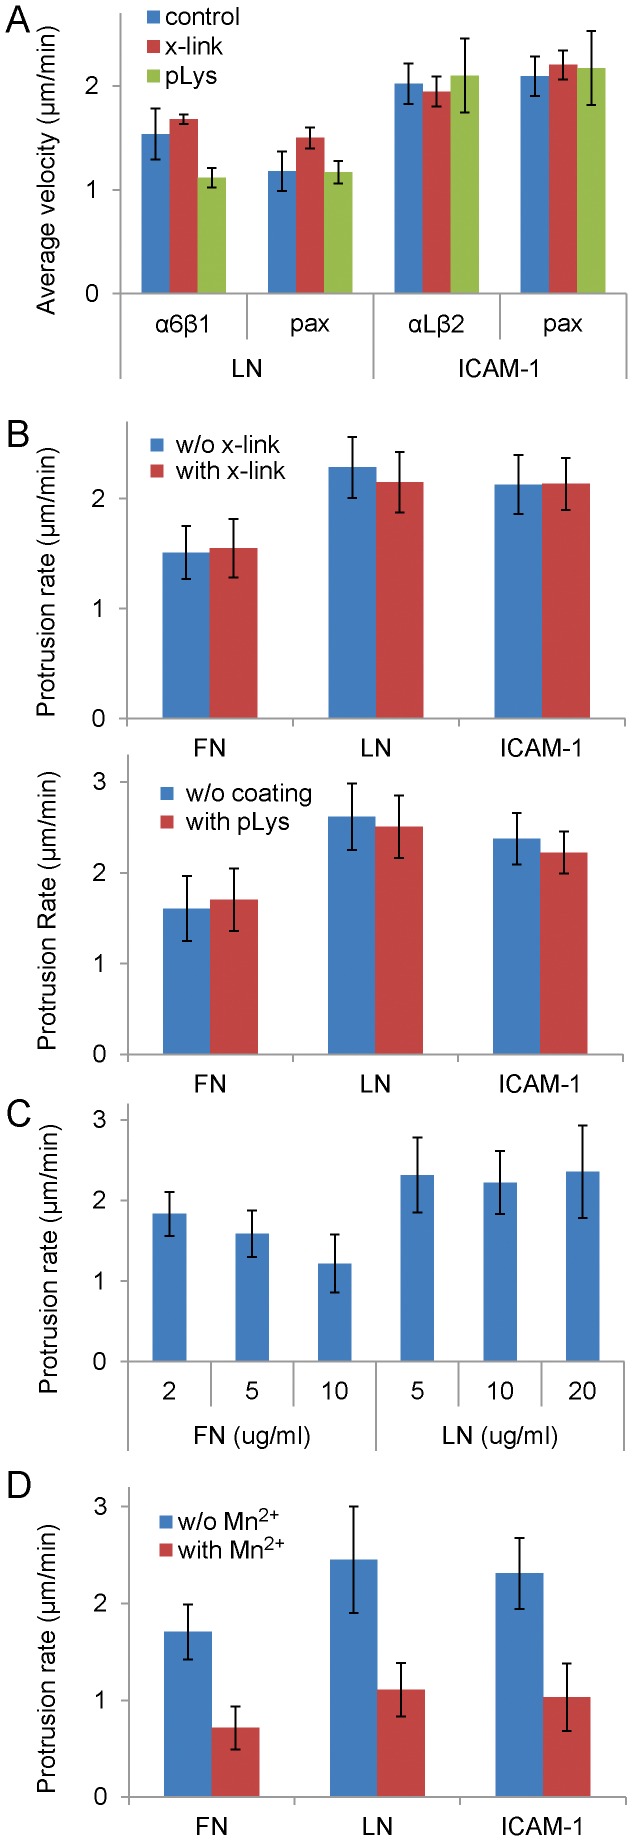
The efficiency of the ECM-actin linkage differs between α5β1 and α6β1 or αLβ2. CHO.B2 cells were doubly transfected with paxillin-Cherry and the indicated integrin (with GFP), then either plated on different concentration of substrates or cross-linked or poly-lysine treated substrates or treated with Mn2+.(A) Fluxing is not affected by covalent cross-linking (x-link) or poly-L-lysine attachment (pLys). CHO-B2 cells doubly transfected with paxillin-Cherry and the indicated integrin (with GFP), then either plated on control, cross-linked or poly-L-lysine attached substrates. Average velocity of protein fluxing was quantified by STICS. Data are expressed as the mean ± SEM (n = 28 cells). Two-way ANOVA reveals that neither poly-L lysine attachment nor crosslinking have a significant effect on the flux velocity (P = 0.48). (B) Covalent cross-linking (Upper) or poly-L-lysine attachment (Lower) of the indicated integrin ligands did not significantly affect protrusion. Data are expressed as the mean ± SD of at least 3 independent experiments (n = 7, 7, 12, 15, 10, 7 for cross-linking, respectively; n = 8, 9, 8, 9, 8, 7 protrusions for poly-lysine, respectively.) Protrusion rates were obtained from kymographs. (C) Protrusion rates of cells expressing α5 or α6 integrins and plated on FN or LN, respectively. On FN, the protrusion rate decreases with increasing concentration (P<0.006). No significant difference was detected with LN. (D) Protrusion of CHO.B2 cells was inhibited by activating integrins with Mn2+ (P<1×10−6). Data are expressed as the mean ± SD of at least 3 independent experiments. (n = 9, 9, 10, 12, 9, 10 protrusions respectively.).